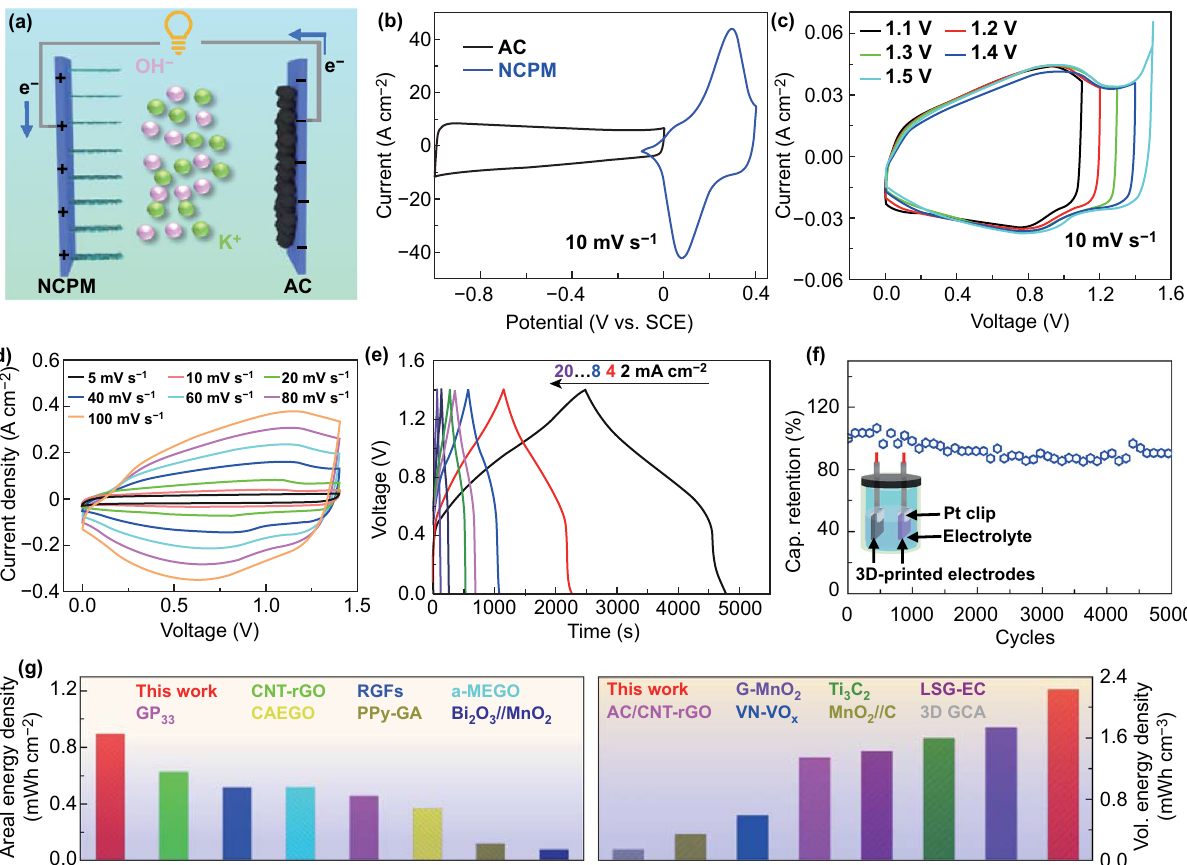
Fig. 5 a Schematic illustration of the constructed ASC full cell based on 3D-printed NCPM positive electrode and 3D-printed AC negative elec- trode. CV curves of b printed NCPM and AC at a scan rate of 10 mV s −1 . c NCPM//AC ASC full cells in different voltage windows. d NCPM// AC ASC full cell recorded at various scan rates. e GCD curves in the voltage range of 0–1.4 V at various current densities. f Cycling perfor- mance of the ASC full cell, with the inset illustrating the 3D-printed ASC tested in aqueous electrolyte. g Comparison of areal and volumetric energy density between our 3D-printed NCPM//AC ASC and other state-of-the-art symmetric/asymmetric